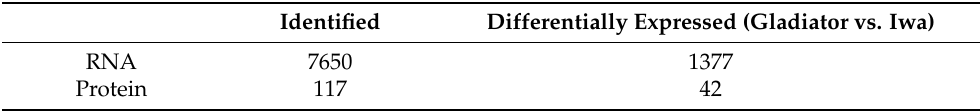
Table 1. The number of identified and significantly changing (FDR < 0.05) transcripts and proteins from S. subterranea inside the resistant and susceptible hosts.